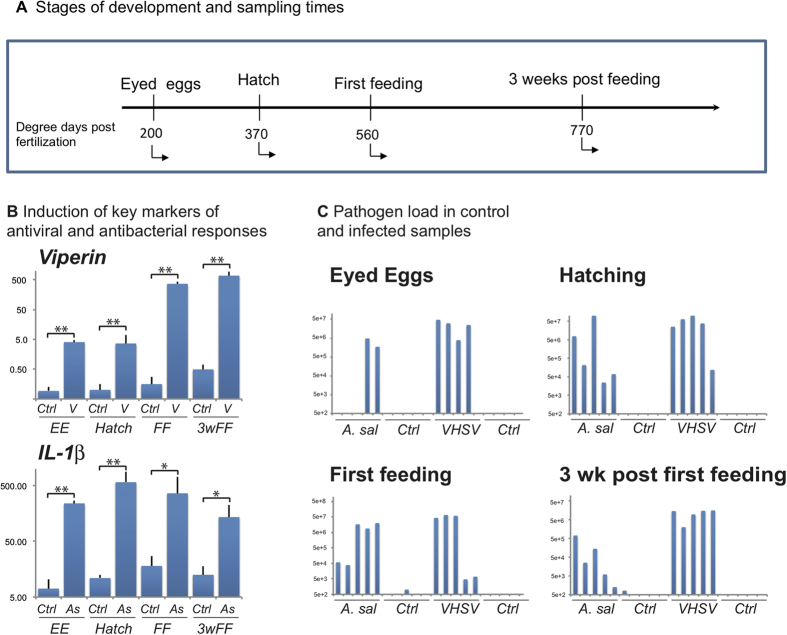
Design of the fish infection and transcriptome experiments.(A) Stages of development and sampling times. (B) Induction of viperin and IL-1β after viral and bacterial injection, respectively (mean ±SE; N = 4), at selected stages of development. Significant differences were determined using unpaired t test (*P < 0.05; **P < 0.001). (C) Pathogen load in control and infected individuals assessed by VHSV or A. salmonicida specific real time PCR assay. The efficiency of each qPCR assay was determined using LinRegPCR. Results are represented in arbitrary units.